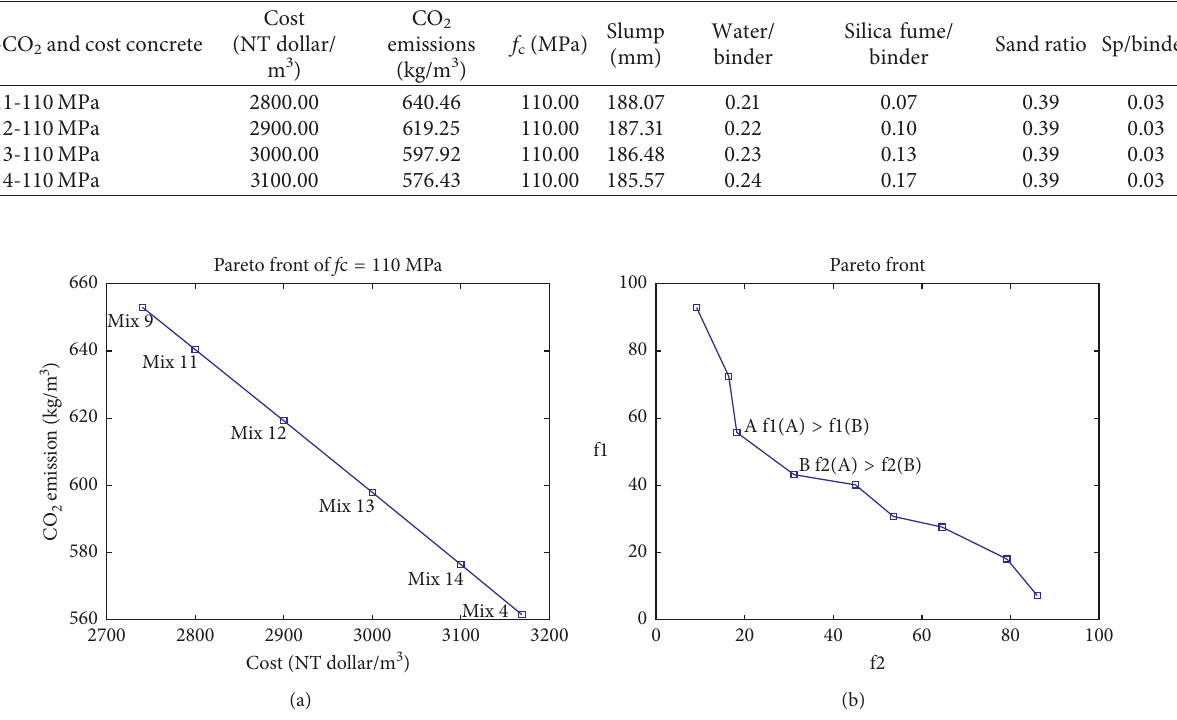
Figure 3: (a) Mixtures for 110MPa concrete with lower CO 2 emissions and lower cost. (b) Illustration of the Pareto optimal solution.